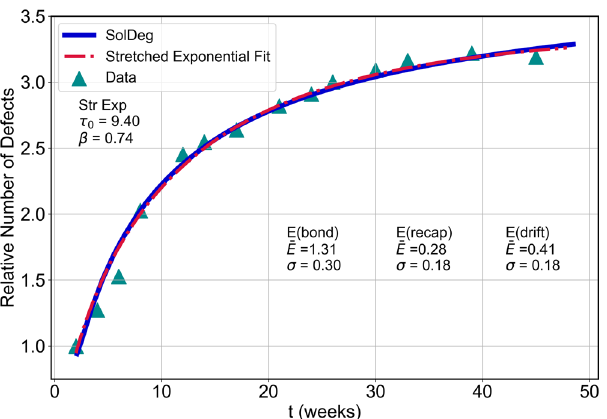
Fig. 4 Defect density N ( t ) determined by SolDeg. The blue line shows our SolDeg-simulated defect density as determined by the expectation value of the solution of the three barrier model using the computed barrier distributions in Fig. 3. The experimentally measured N ( t ) is shown with the turquoise triangles. The SolDeg-simulated blue line is not a fi t: only the over all scale factor was selected to match the measured data. Also shown: stretched exponential fi t to the experimental data, with red dashed line.